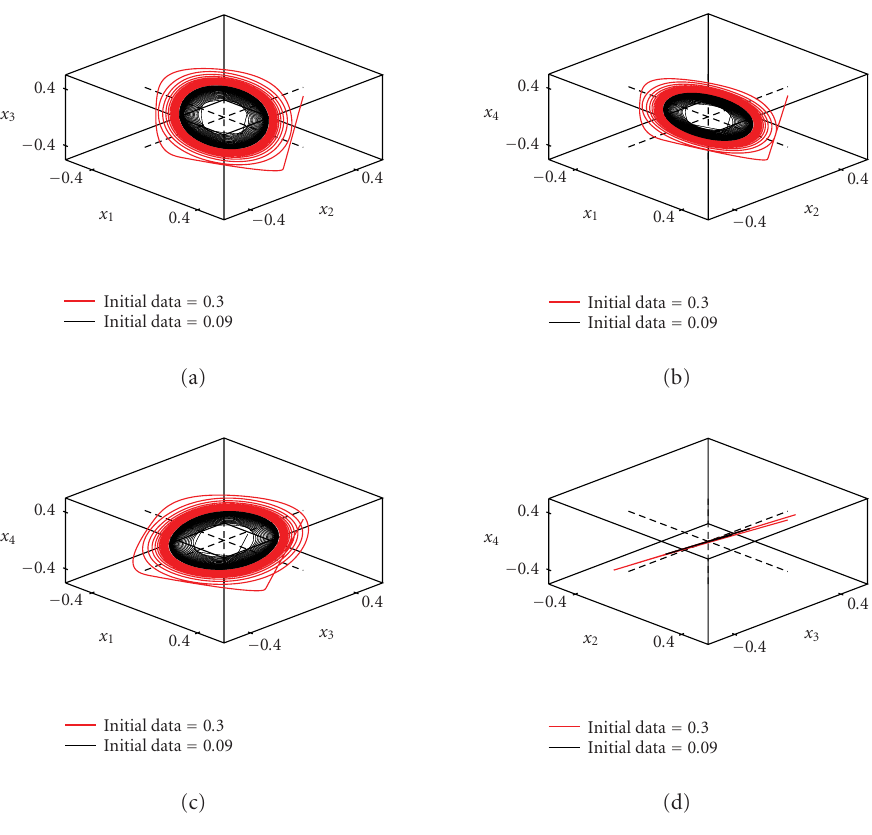
Figure 5.5. The projections in three-dimensional spaces of the orbit of system (5.14) with τ 1 = 1 . 2, τ 2 = 1 . 3, and initial data x 1 ( t ) = x 2 ( t ) = x 3 ( t ) = x 4 ( t ) = 0 . 3, and 0 . 09, t ∈ [ − 1 .